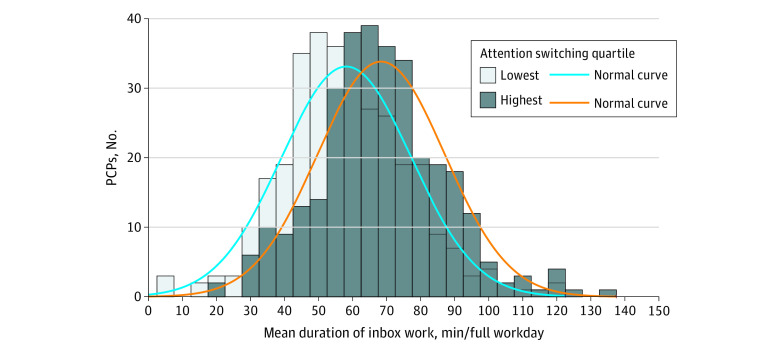
Distribution of Primary Care Physicians (PCPs) by Inbox Work DurationAttention switches are shown for PCPs in the highest vs lowest quartile.